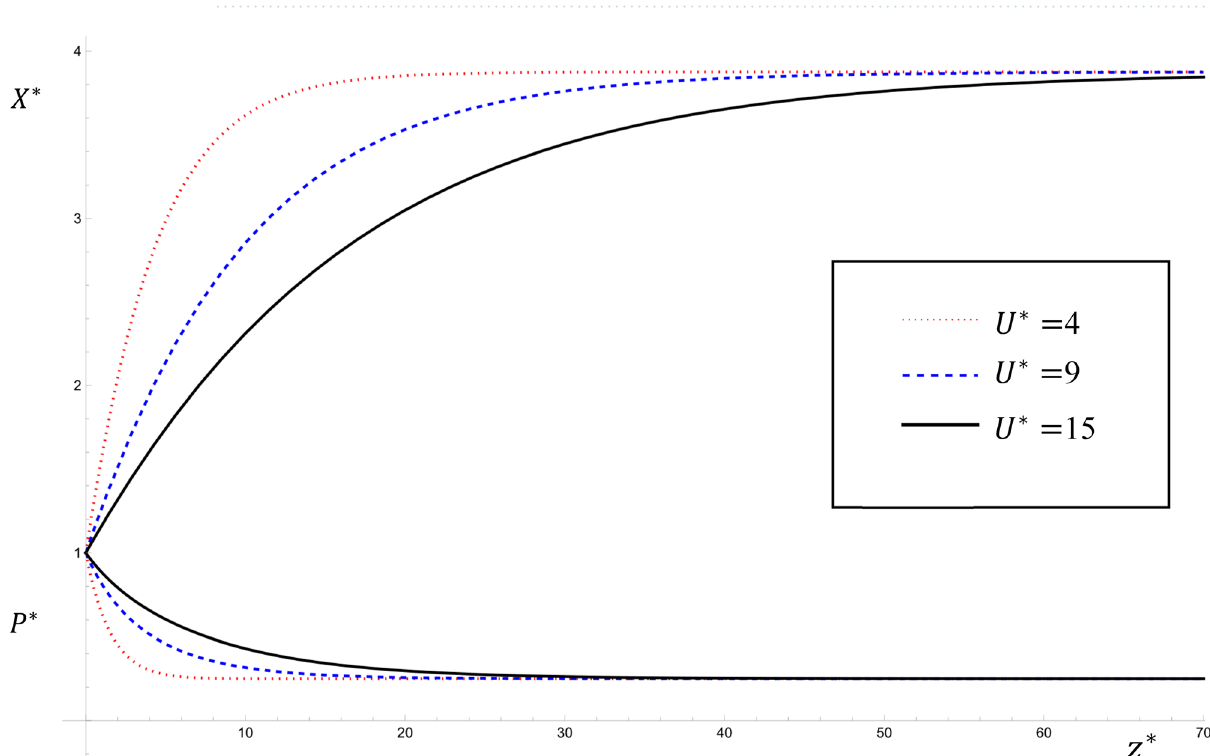
4, 9, 15 for the steady state analytical =